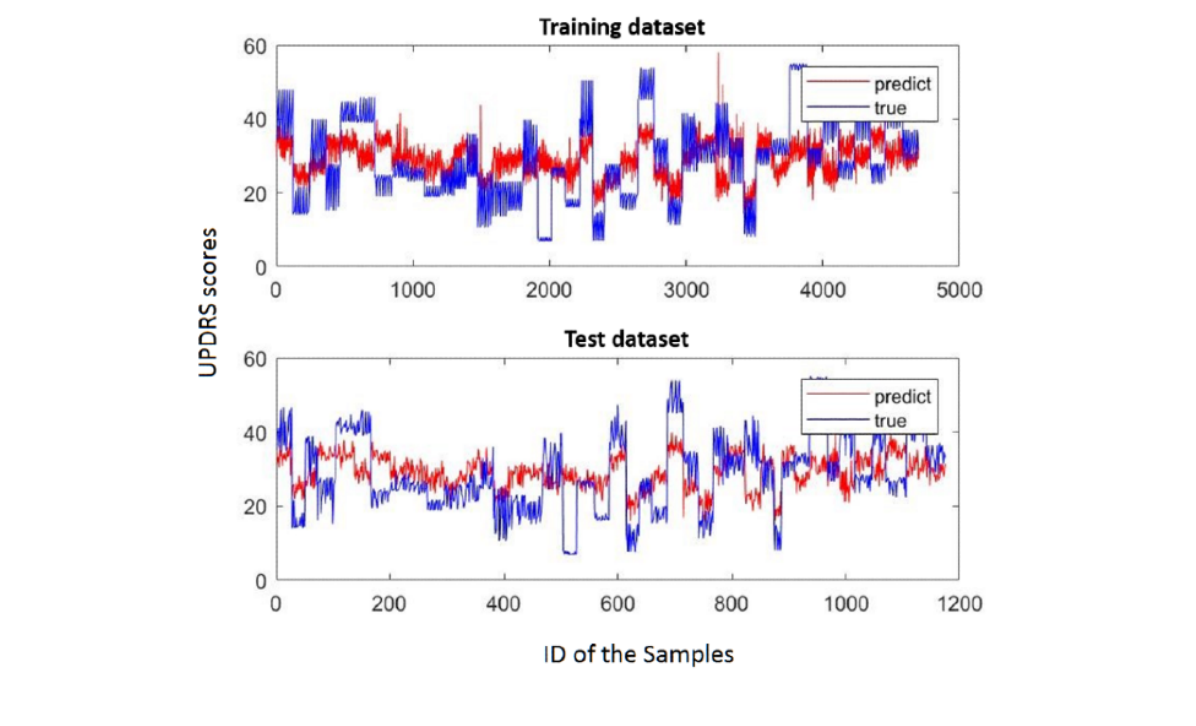
Figure 5. Least absolute shrinkage and selection operator (LASSO) fitting. The red line is the predicted value and the blue line is the true value. UPDRS: Unified Parkinson's Disease Rating Scale.